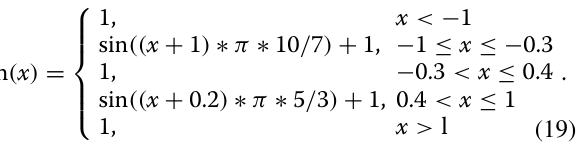
Second boundary x from 0.5 to 0.5 −